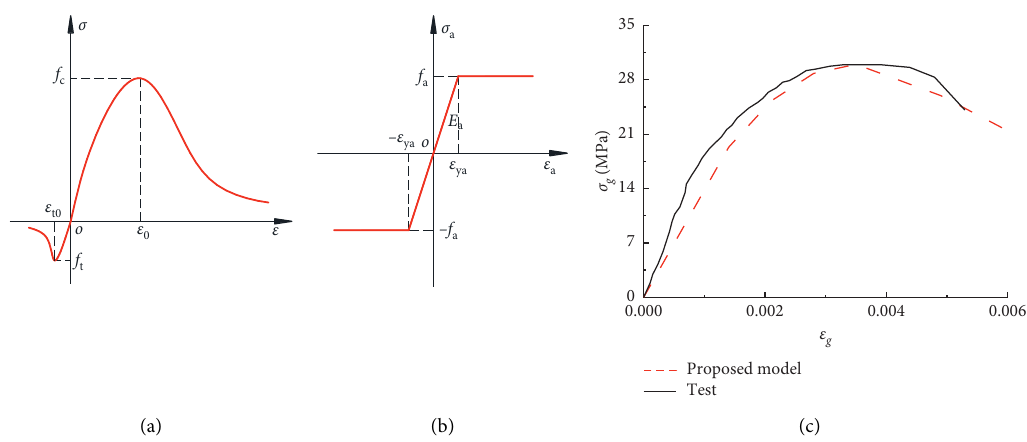
Figure 1: Constitutive relationship of materials. (a) Concrete. (b) Steel tube. (c) Grouting